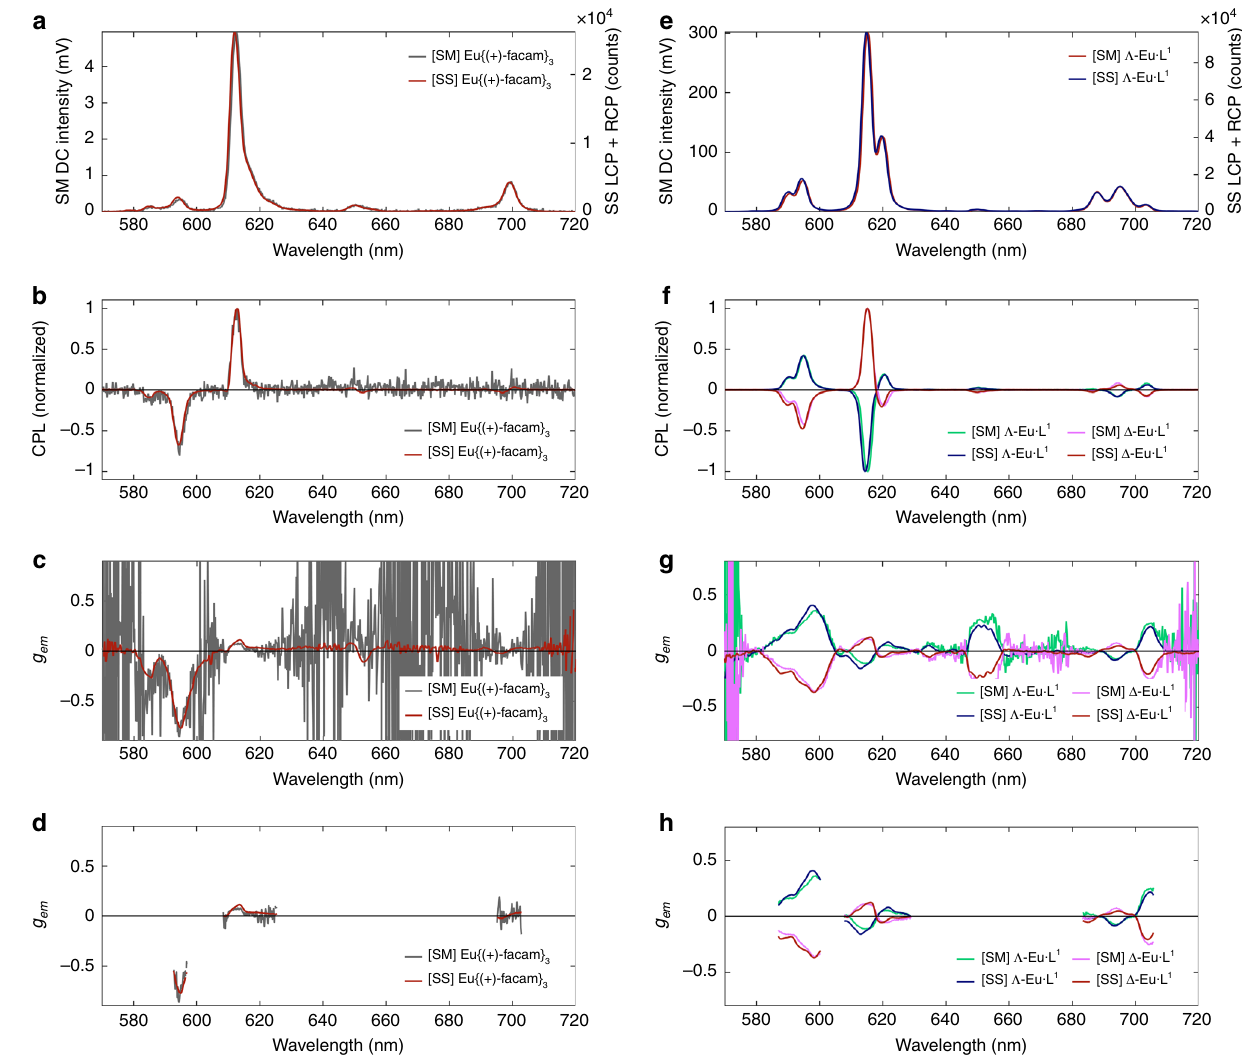
Fig. 2 Close agreement between SM-CPL and SS-CPL spectrometers demonstrated by measuring CPL of two reference complexes. 5.5 mM Eu {( + )-facam} 3 in anhydrous DMSO: a Total intensity, b CPL, c raw g em , d g em (threshold cut-off 0.22 mV [SM-CPL total intensity]). 18 µ M Eu·L 1 dissolved in a 50:50 mixture of MeCN and MeOH: e Total Intensity. f CPL, g raw g em , h thresholded g em (threshold cut-off 4 mV [SM-CPL total intensity]). Both samples were excited at 365 nm. See the Methods section for scan settings.